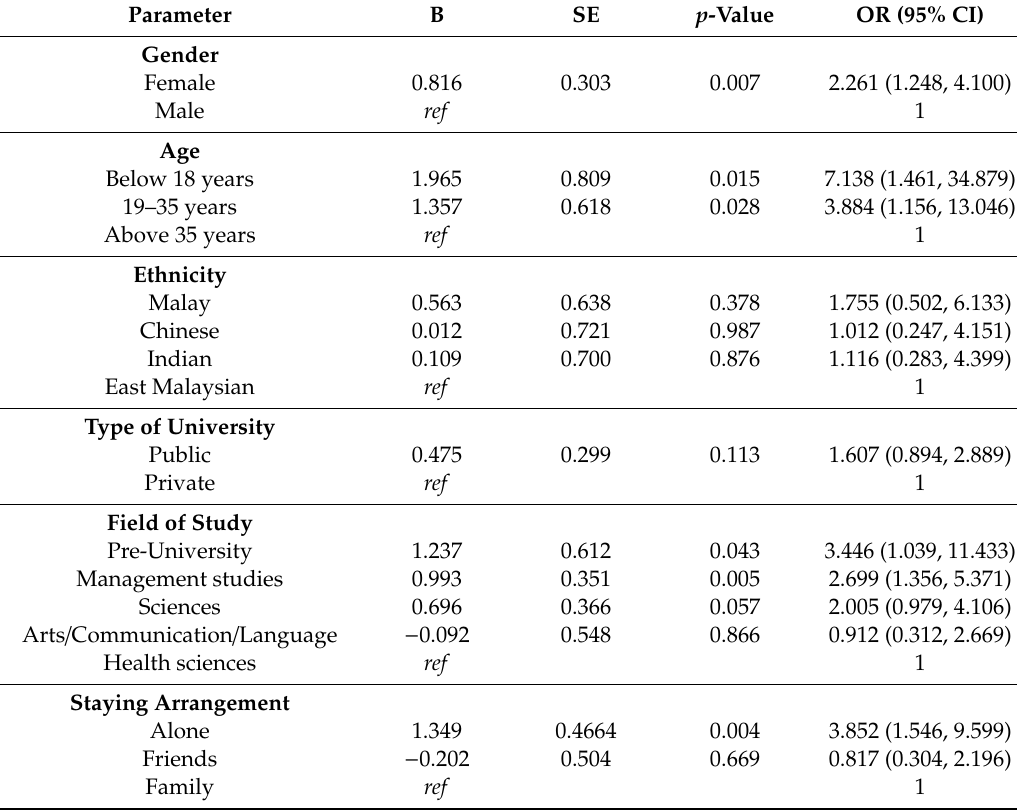
Table 4. Results from ordinal multivariate